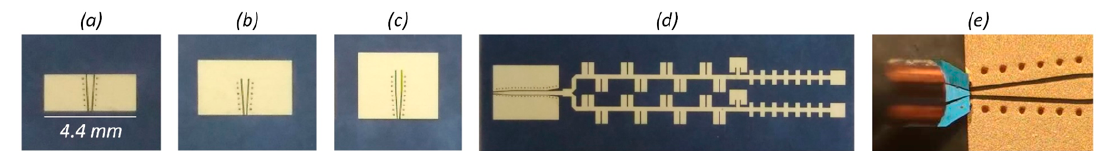
Figure A2. Different structures measured for probe de-embedding in S -parameter measurements: ( a ) open-circuit, ( b ) short-circuit, ( c ) translated short, and ( d ) DUT. In this example it consist of a two-row stub array. ( e ) Detail of the probe tip and tapered interconnection shared among structures.